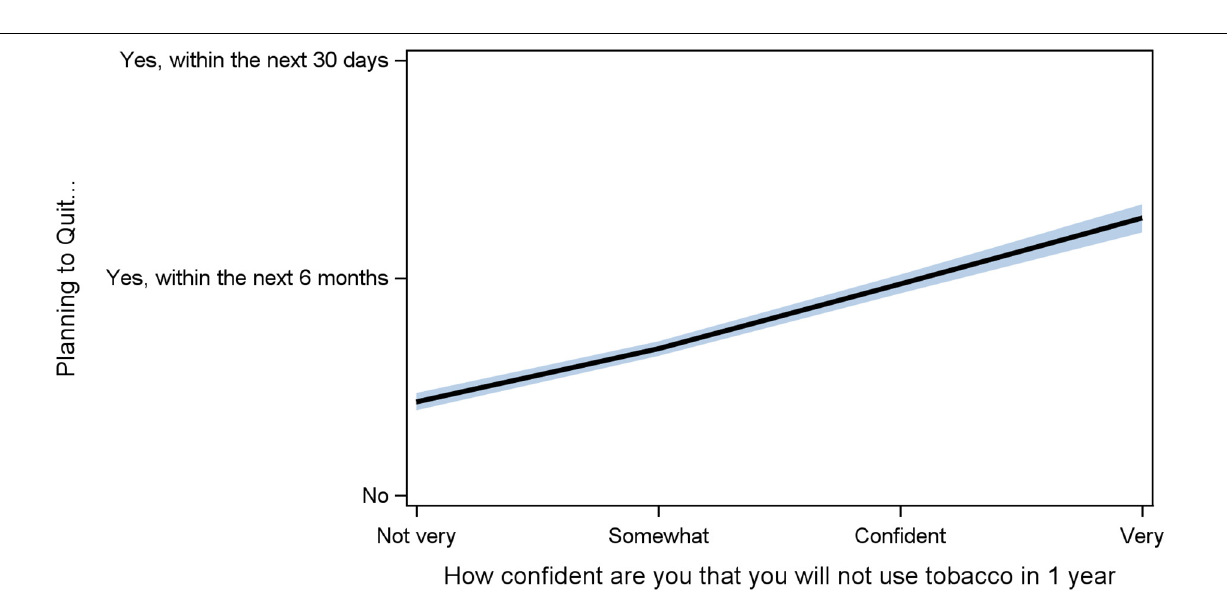
FIGURE 2 | Association between confidence in not using tobacco (self-efficacy) and planning to quit. The Y -axis is planning to quit (Not, within 6 months, with 30 days). The X -axis is the level of confidence (0–3: not very, somewhat, confident, very). The black line is the fitted slope for responses. The blue shadow is the 95% confidence